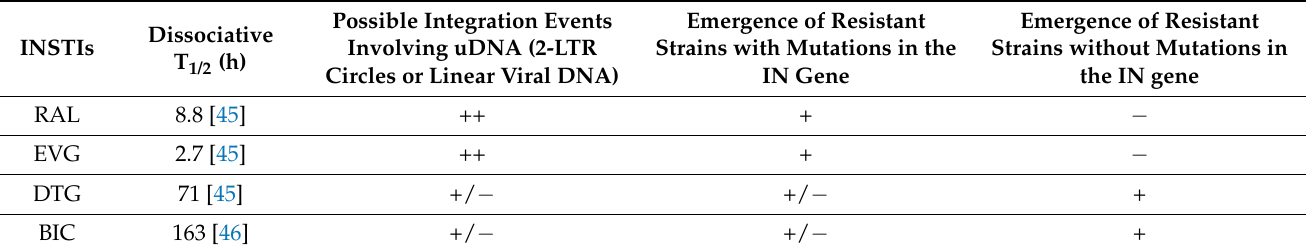
Table 2. Possible correlation between INSTI dissociation half-life (T1/2) and